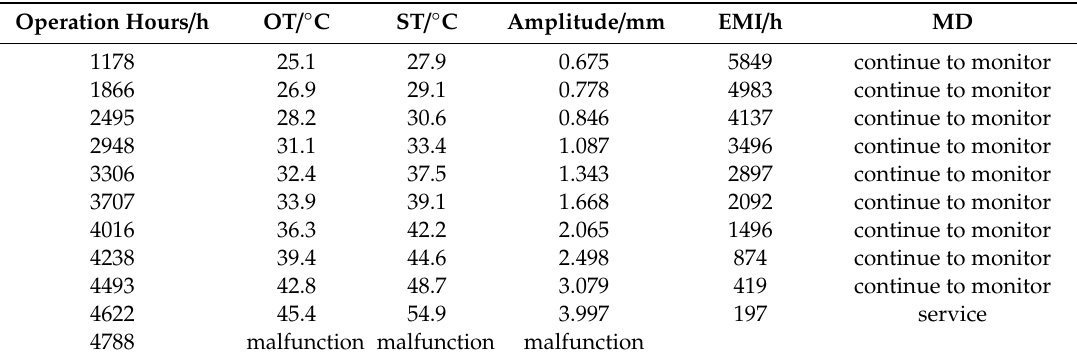
Table 3. Estimated maintenance interval and maintenance